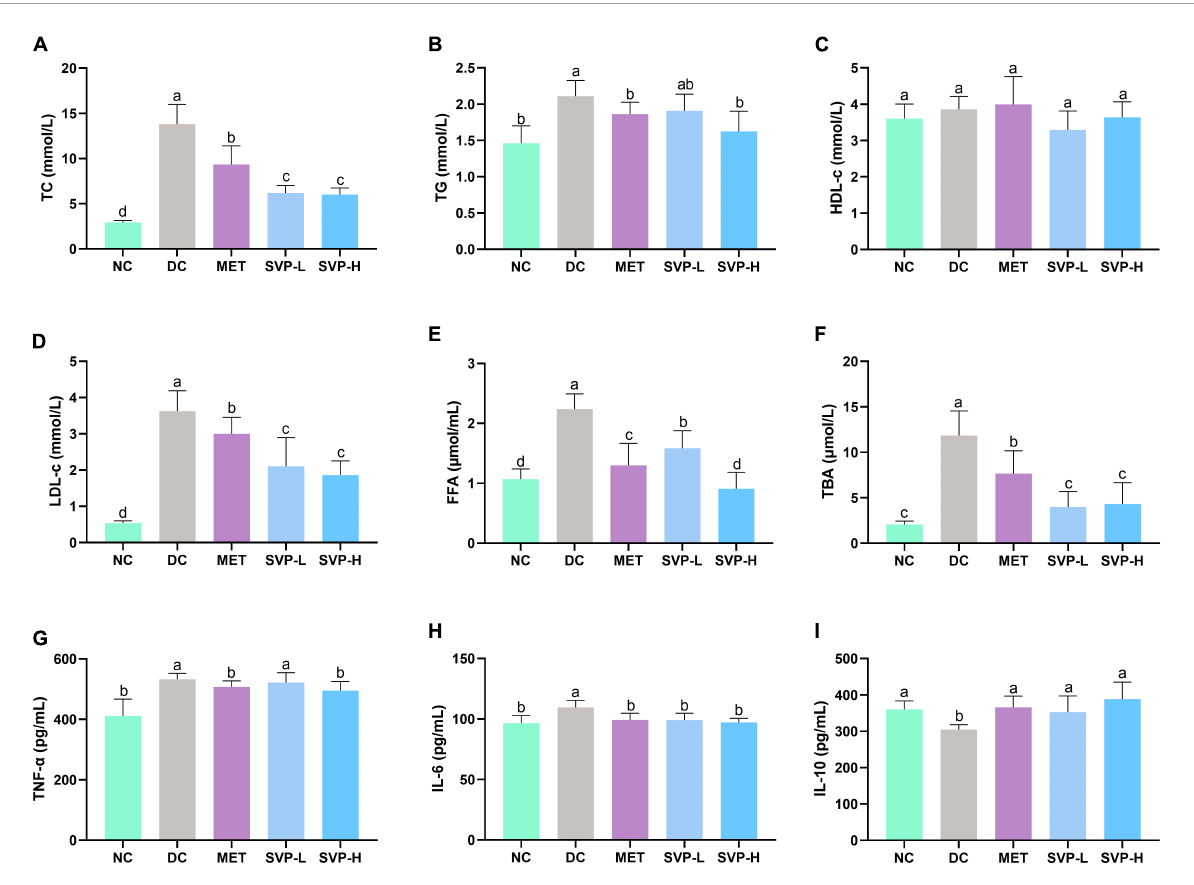
FIGURE4 Effects of oral SVP on the lipid metabolism and inflammation-related indexes in T2DM mice. (A) Total cholesterol levels; (B) total triglyceride levels; (C) high-density lipoprotein-cholesterol levels; (D) low-density lipoprotein-cholesterol levels; (E) free fatty acid levels; (F) total bile acid levels; (G) tumor necrosis factor- α ; (H) interleukin-6 levels; (I) interleukin-10 levels. Different superscript letters indicate statistically significant differences between the groups ( p <